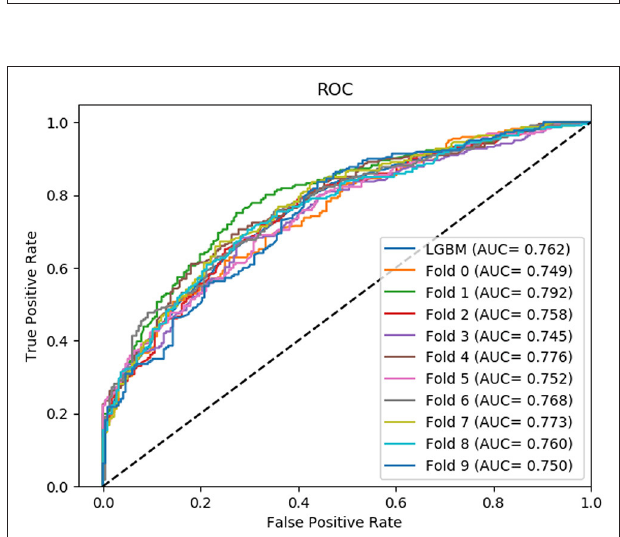
FIGURE 4 | The ROC curve of dataset RPI488 on 10-fold cross- validation.